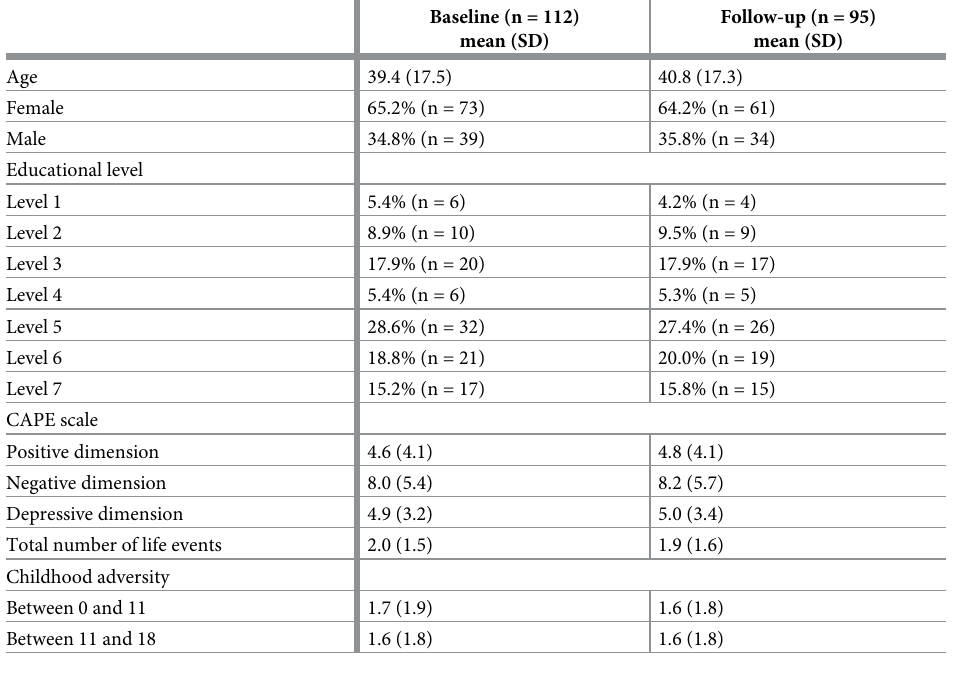
Table 1. Summary of selected demographic variables and